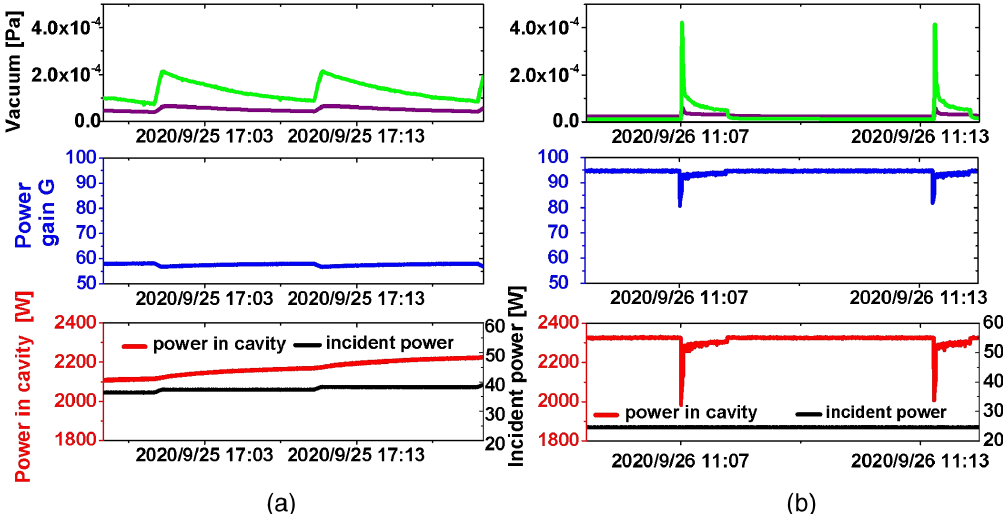
FIG. 25. Different behaviors of the proof-of-principle structure caused by (a) the sustainable multipacting and (b) the unsustainable multipacting. (a) corresponds to the faded area in Fig. 23 and (b) corresponds to the faded area in Fig. 24.